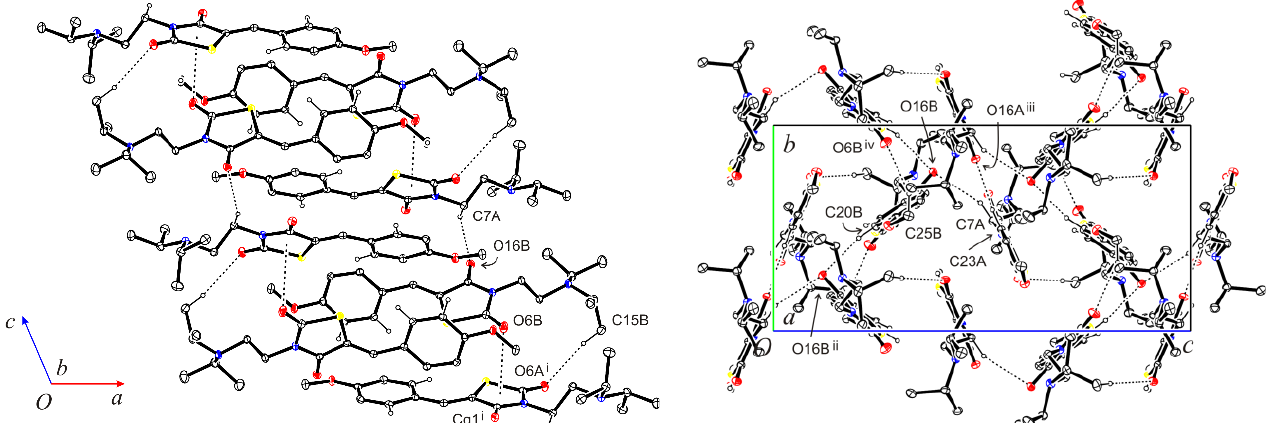
Figure 4. The C –H∙∙∙O hydrogen bonding and C=O∙∙∙ Cg 1 intermolecular interactions in the crystal structure of 3 . The H atoms not involved in hydrogen bonds have been omitted for clarity; Cg 1 = thiazolidin-2,4-dione system. Table 1. Hydrogen bonds and Y- X∙∙∙ Cg interactions in the crystal structure of 3 .